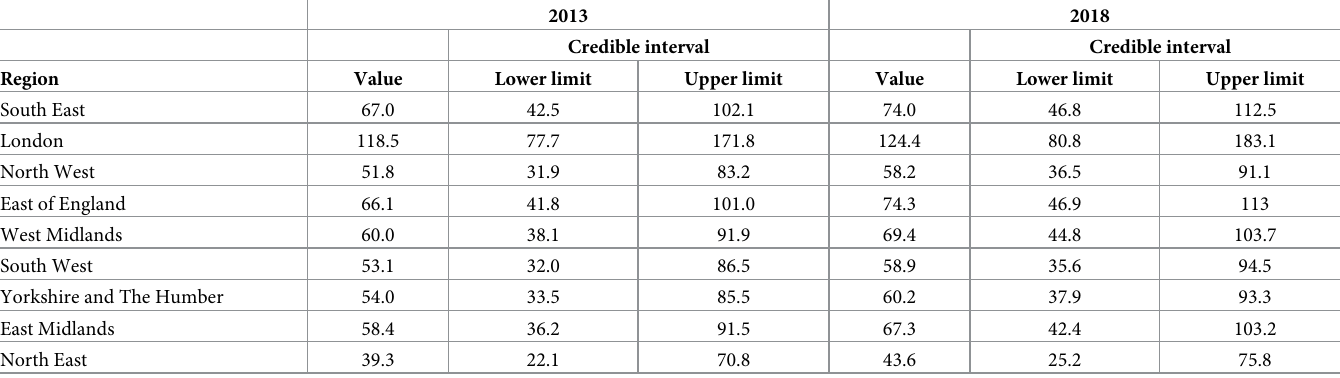
Table 2. Estimated number of livebirths to HCV seropositive women per 100,000 livebirths, together with 95% credible